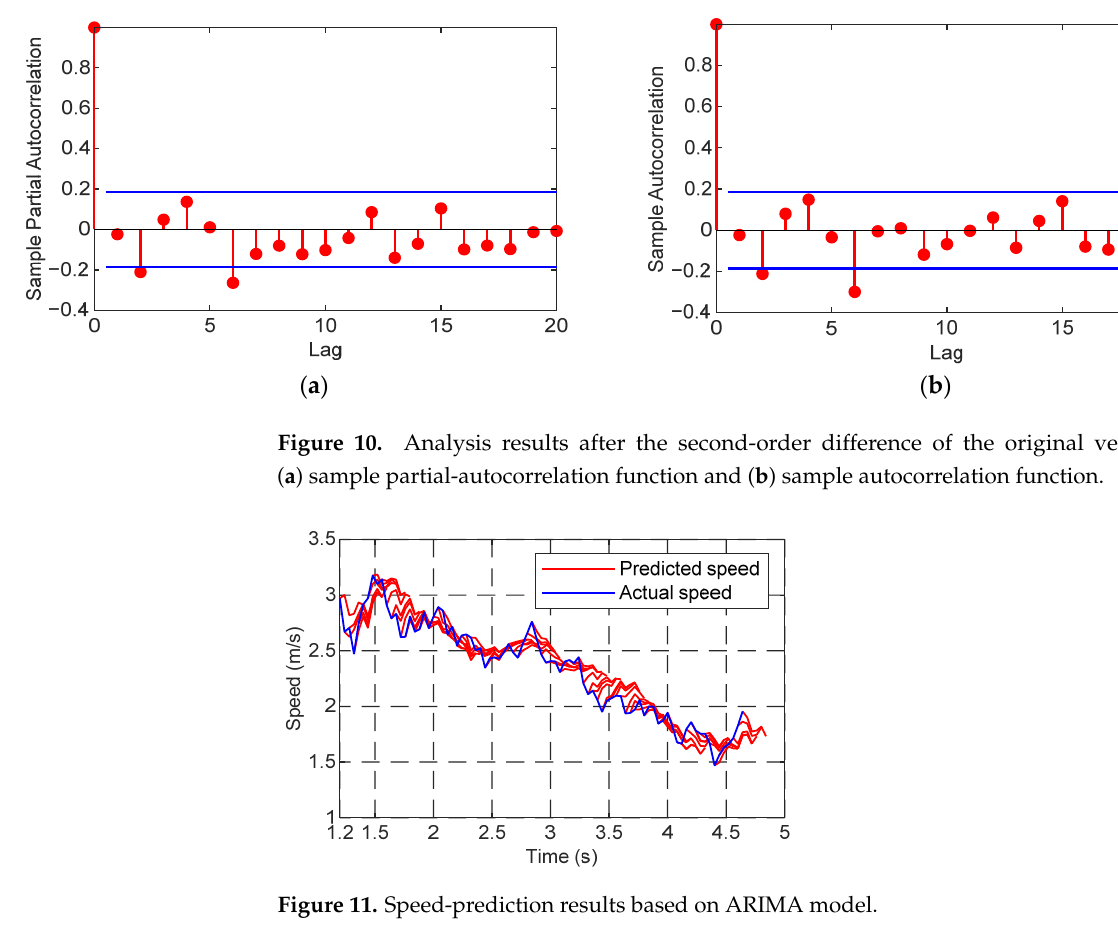
Figure 11. Speed-prediction results based on ARIMA model.